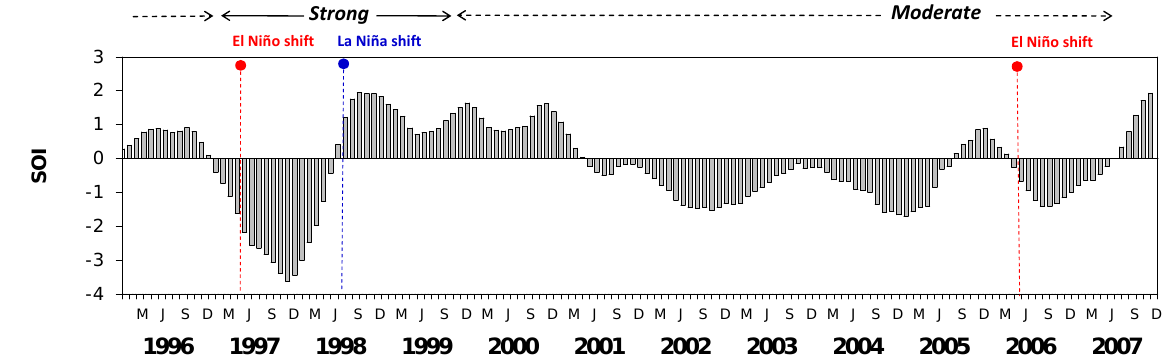
Fig. 2. The Southern Oscillation Index (SOI) that illustrates the main El Ni˜no and La Ni˜na events over 1996–2007 period. El Ni˜no and La Ni˜na periods correspond to negative and positive SOI values, respectively. During this period, strong and moderate El Ni˜no and La Ni˜na periods are denoted by continuous or dashed arrows, respectively. The times when we observe significant shifts in PFT dominance are denoted by vertical dashed lines (cf. Fig. 5e and